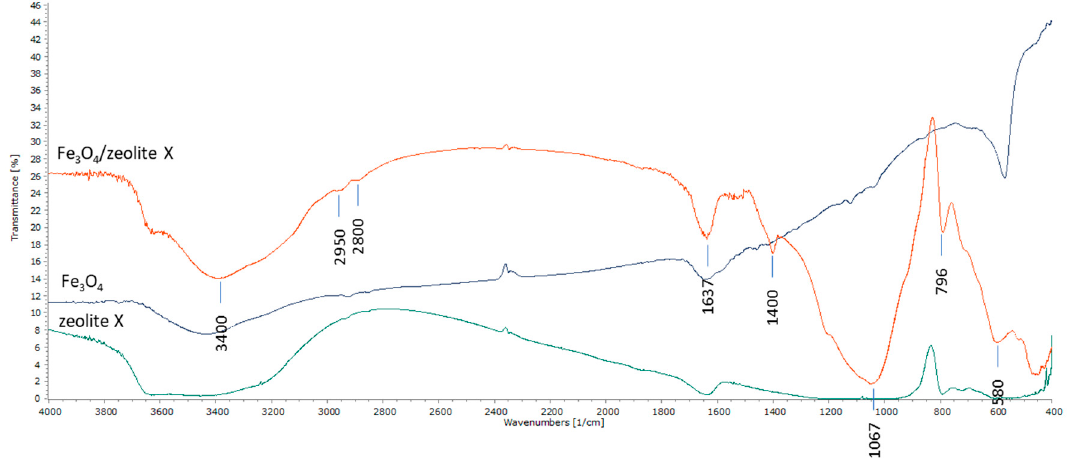
Figure 6. Fourier transformation infrared (FTIR) spectra for magnetite (Fe 3 O 4 )/zeolite-X composite particles, magnetite (Fe 3 O 4 ) nanoparticles and pure zeolite-X sample .